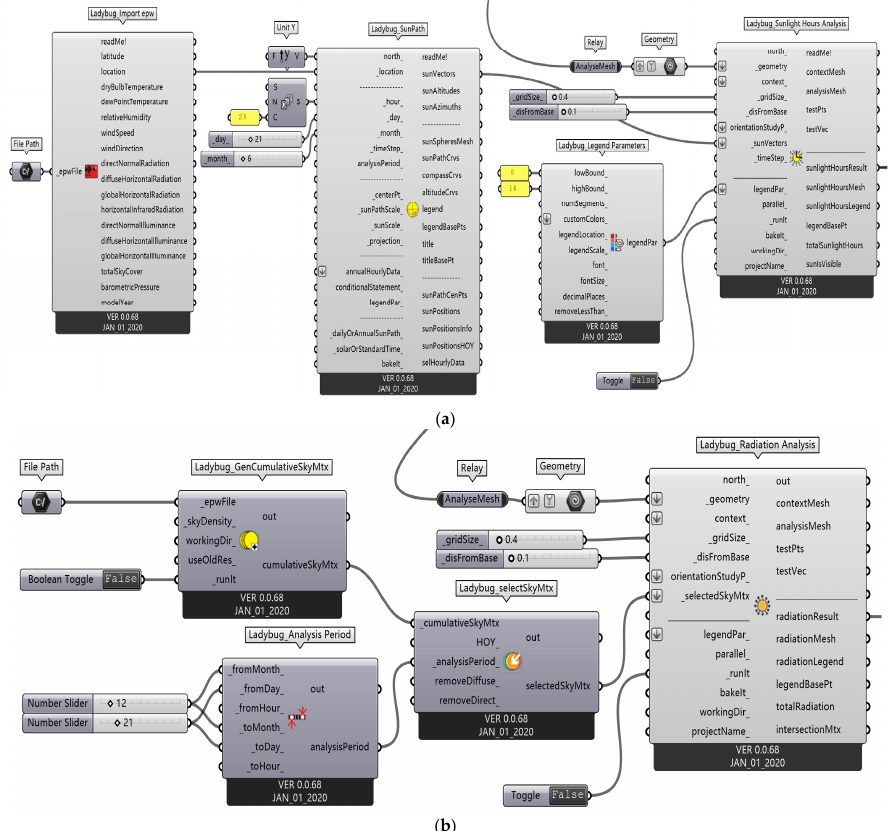
Figure 8. Simulation methods for ( a ) sunlight hours and ( b ) sunlight radiation (self-developed).